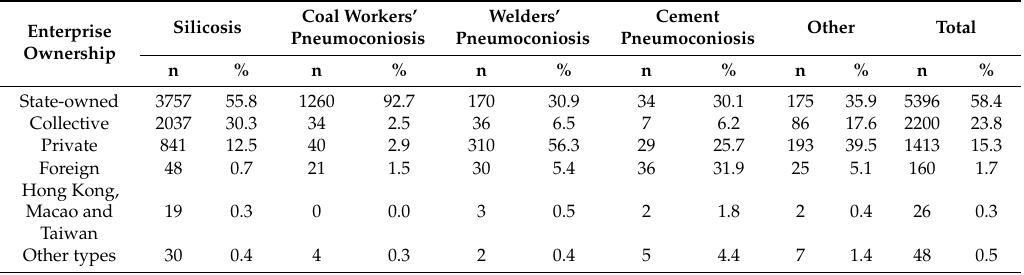
Table 2. The enterprise ownership type distribution of pneumoconiosis cases reported from 2006 to 2015.